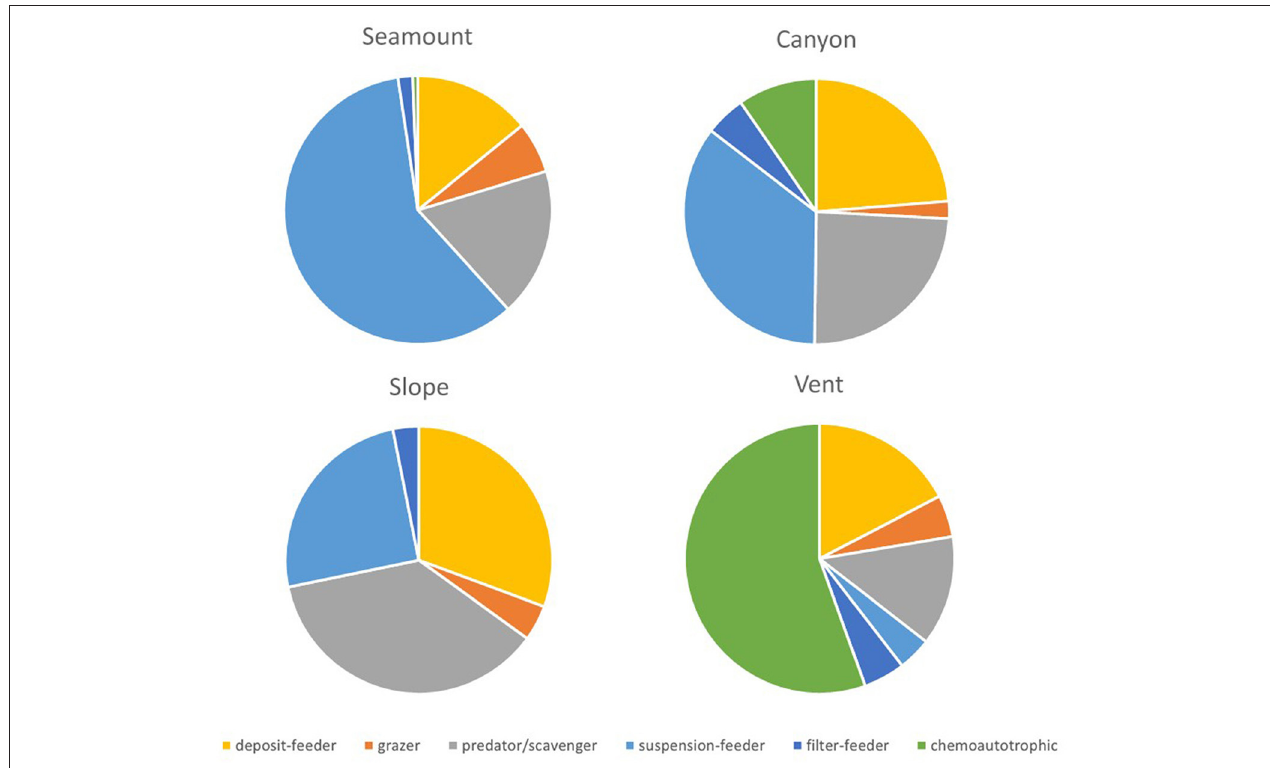
FIGURE 5 | Mean proportions of feeding groups for megafauna at seamount, canyon, slope and vent habitats in the Bay of Plenty region at the shallow strata (700 and 1000 m). Trophic structure was not significantly different between habitats in the Hikuangi Margin at the shallow strata, so corresponding results are not